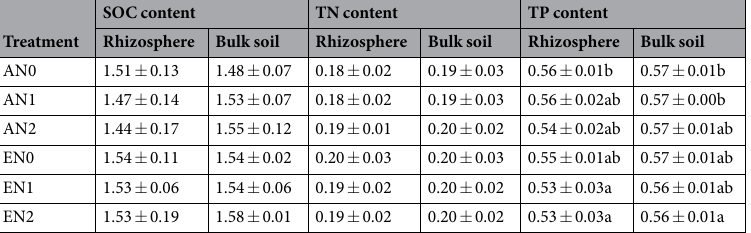
Table 2. Soil organic carbon (SOC), total nitrogen (TN), and total phosphorus (TP) contents (g kg − 1 ) in the rhizosphere and bulk soil in the treatments. Different letters within a column indicate significant differences between treatments.